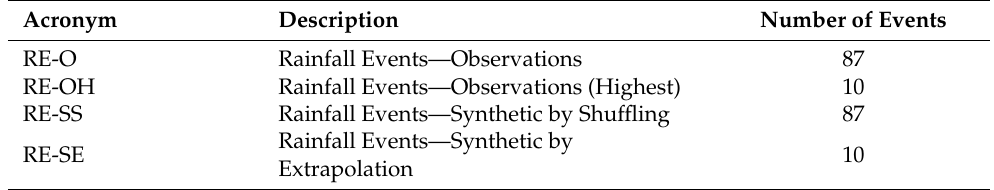
Table 1. Summary of sub